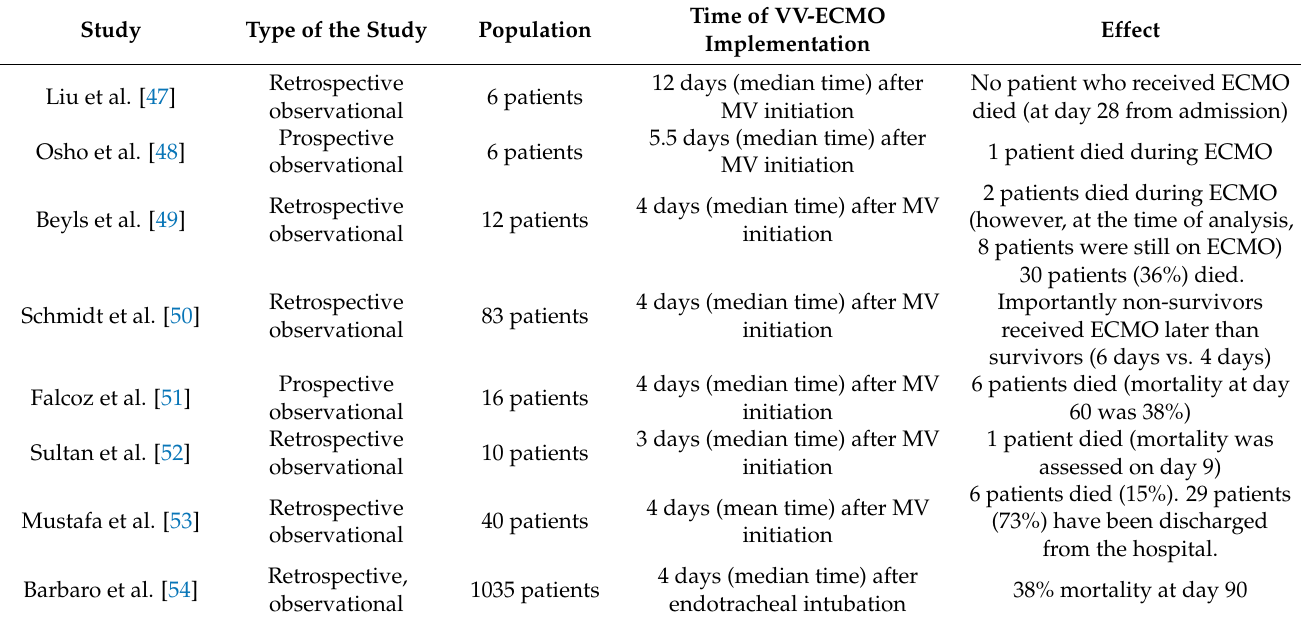
Table 5. A summary of trials in which VV-ECMO was implemented in severe acute respiratory failure associated with COVID-19 (as of 15 November 2020). MV—Mechanical ventilation.